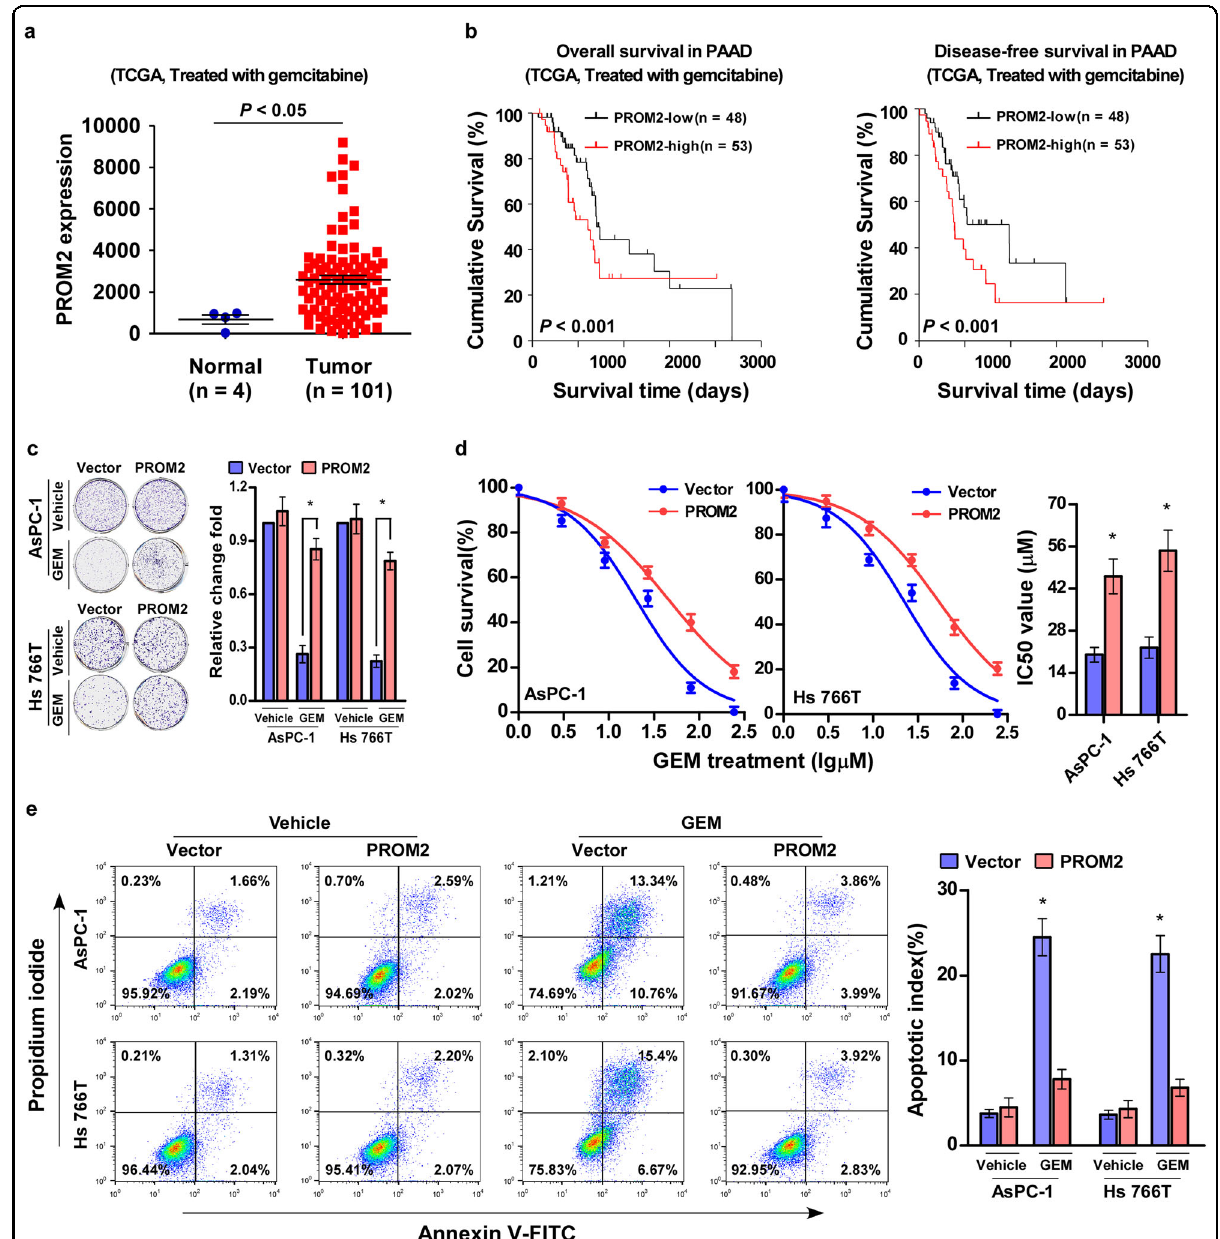
Fig. 2 PROM2 upregulation promotes gemcitabine chemoresistance in pancreatic cancer. a The expression level of PROM2 in pancreatic cancer patients treated with gemcitabine. b High expression of PROM2 in pancreatic cancer patients treated with gemcitabine indicates poor overall and disease-free survival ( P < 0.001, P < 0.001; TCGA, n = 101). c Representative images (left) and quanti fi cation (right) of colonies generated with the indicated cells treated with vehicle or gemcitabine (10 μ M). The numbers of clone formation of AsPC-1/vector or Hs 766T/vector has been set for control at 1 (mean± SD, n = 3; * P < 0.05). d MTT cell viability assay (left) at different concentrations and IC 50 value of Gemcitabine (right, 10 μ M) in the indicated cells (mean ± SD, n = 3; * P < 0.05). e FACS analysis of Annexin-V and PI staining (left) and quanti fi cation (right) of indicated cells treated with Gemcitabine (10 μ M) (mean± SD, n = 3; * P <